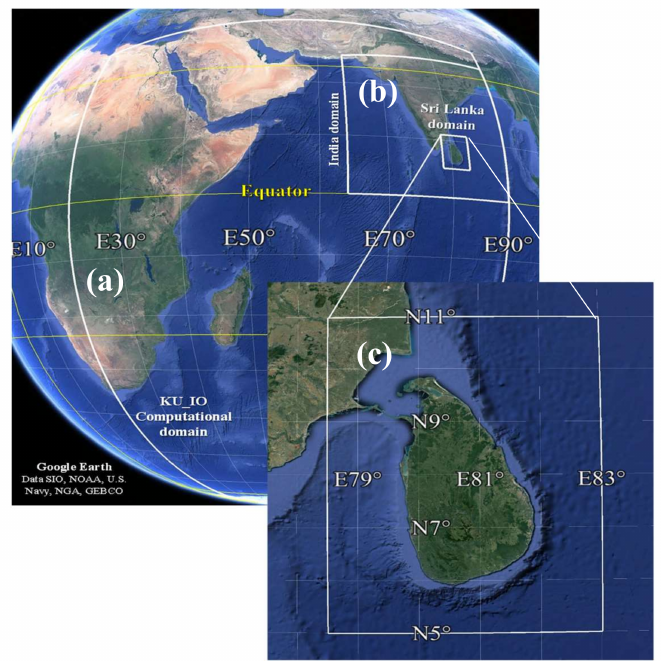
Figure 3. Indian Ocean KU_IO ( a ), India regional (KU_IND) ( b ) and Sri Lanka local (KU_SLK) ( c ) SWAN wave model domains used to generate wave projections for the Sri Lanka region (Google